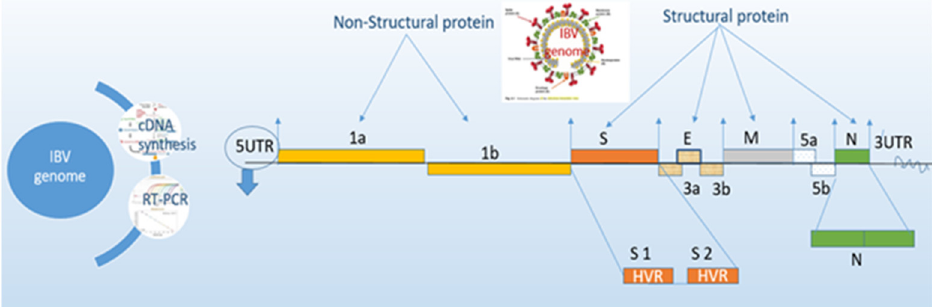
Figure 1. Morphology and genomic structure of infectious bronchitis virus (IBV) with different structural and non-structural genes.